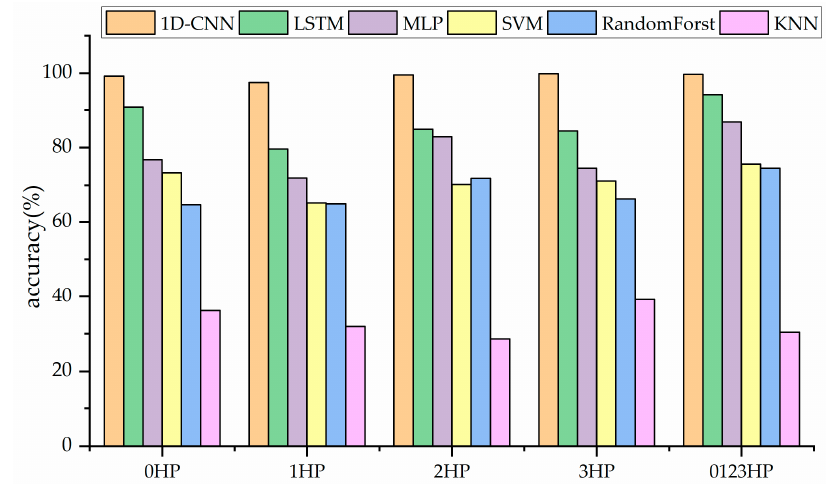
Figure 11. Accuracy of different models under different